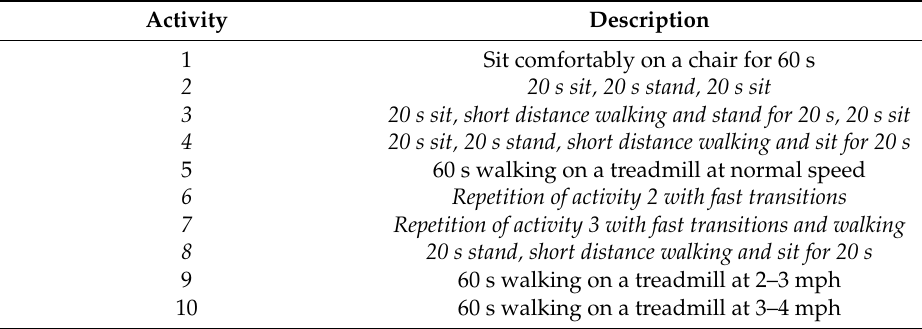
Table 1. Data collection protocol—activities list.